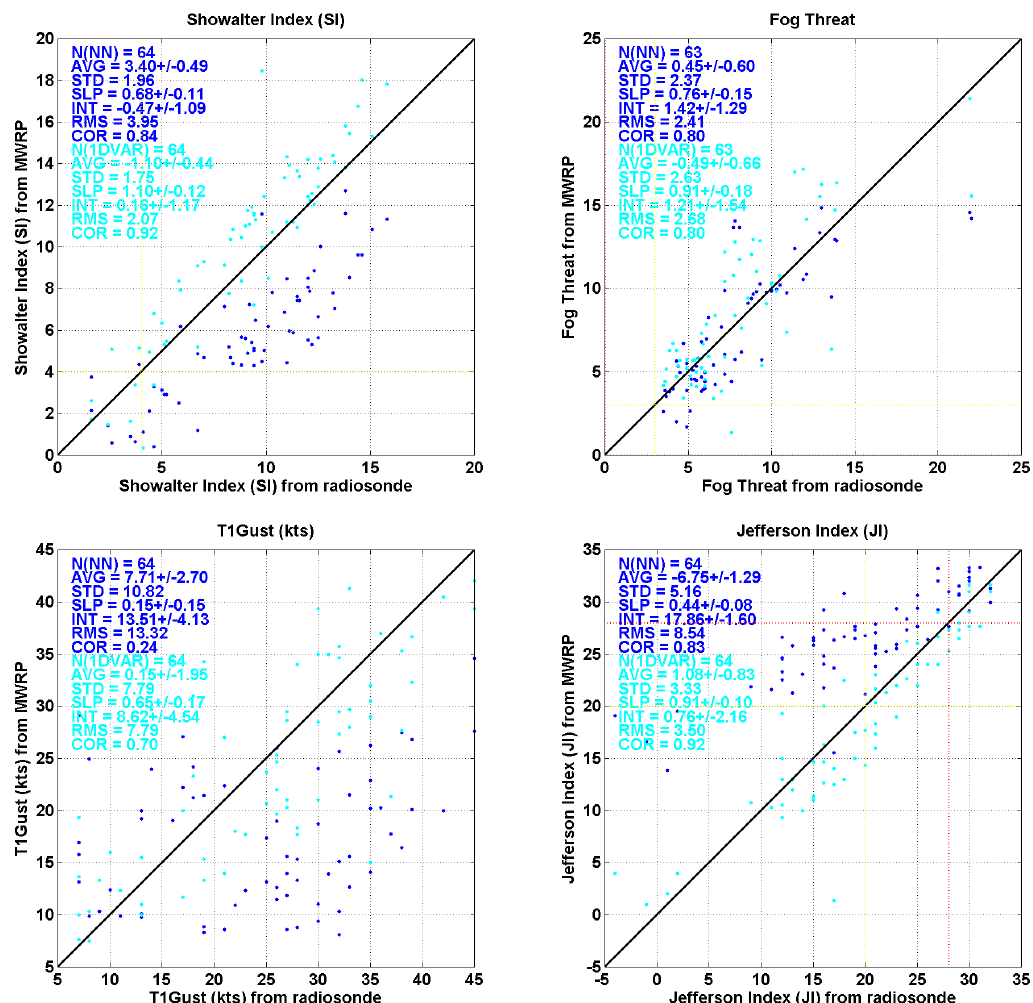
Figure 9. As in Fig. 6 but for (clockwise from top-left panel) Showalter index, fog threat, T1 gust, and Jefferson index. Dotted yellow and red lines indicate thresholds for moderate and high potential, respectively (where